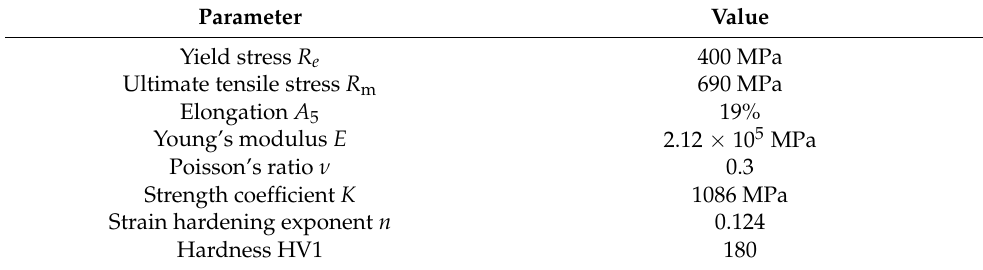
Table 1. Selected mechanical properties of the C45 steel used in the tests.